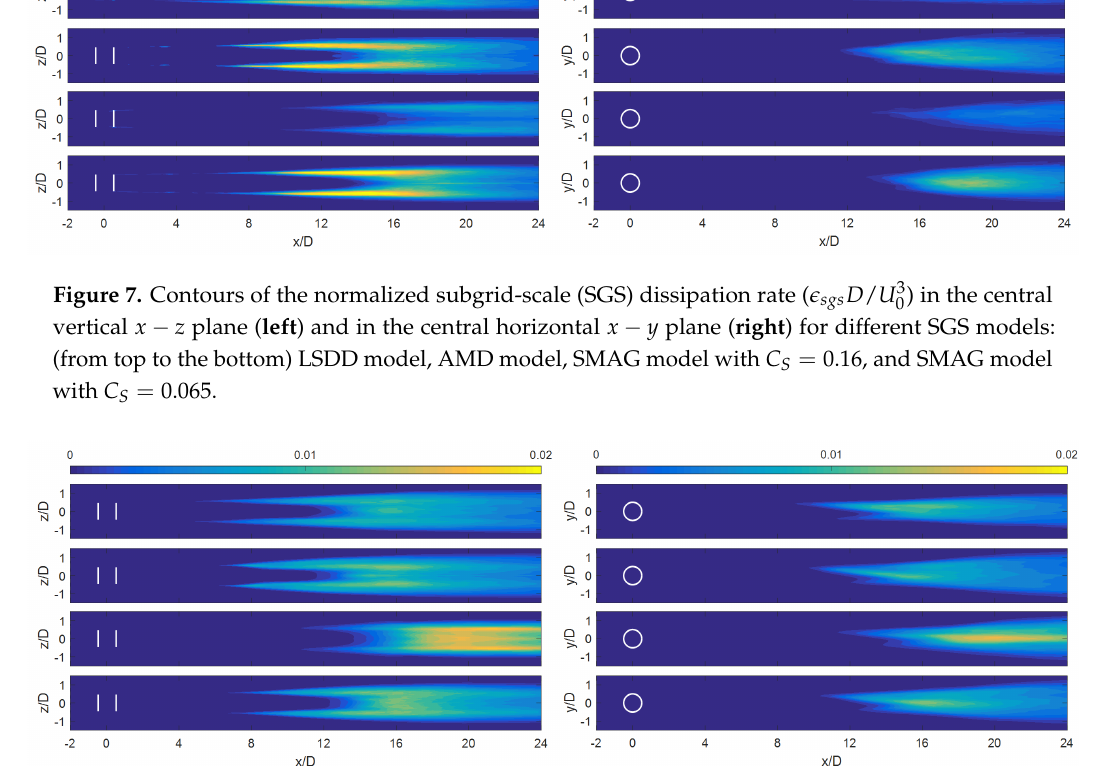
Figure 8. Contours of the normalized turbulent kinetic energy (TKE) (¯˜ k / U 2 plane ( left ) and in the central horizontal x − y plane ( right ) for different SGS models: (from top to the bottom) LSDD model, AMD model, SMAG model with C S = 0.16, and SMAG model with C S =